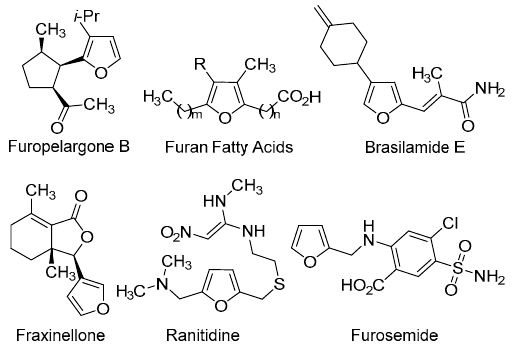
Figure 1. Some furan-based medicines and natural products.